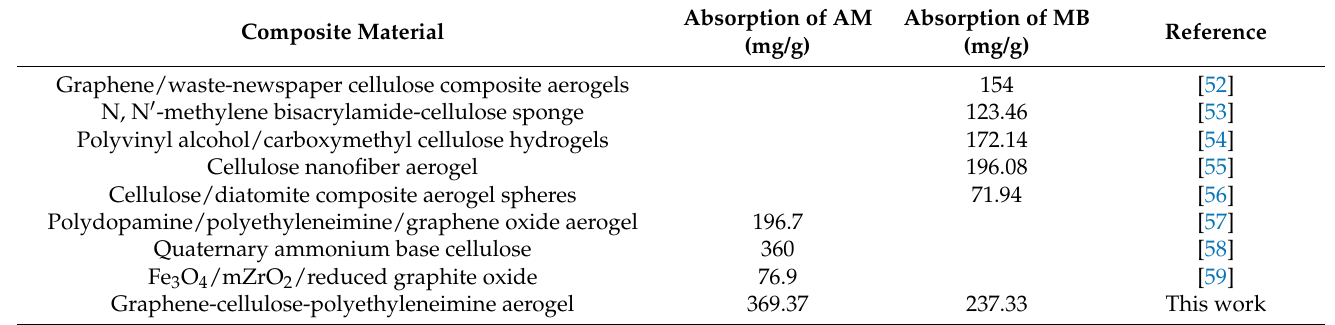
Table 5. Maximum absorption capacities of MCC composites, GA composites, and PEI composites as adsorbents for amaranth or methylene